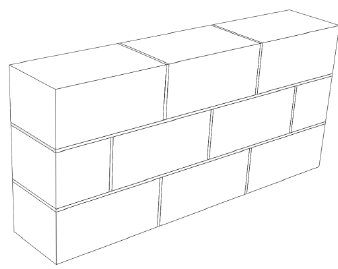
Figure 2. Schematic diagram of the three-layer staggered-joint wall.